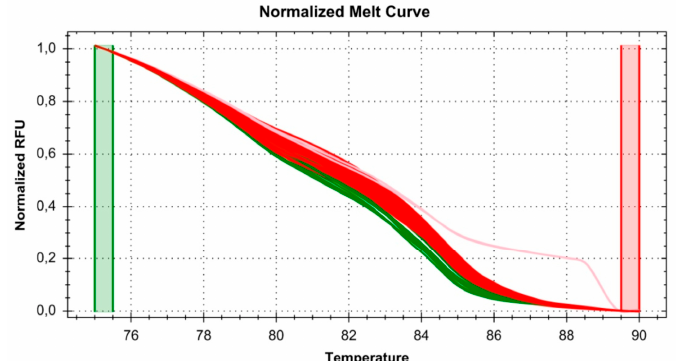
Figure 4. Example of the High Resolution Melt (HRM) assay from scanning 95 DNA samples, run in duplicate. The red cluster is for the reference sequence; the green cluster is for the heterozygous variant of the rs116171003 polymorphism; the pink cluster is for the homozygous variant of the rs116171003 polymorphism. RFU, relative fluorescence units.